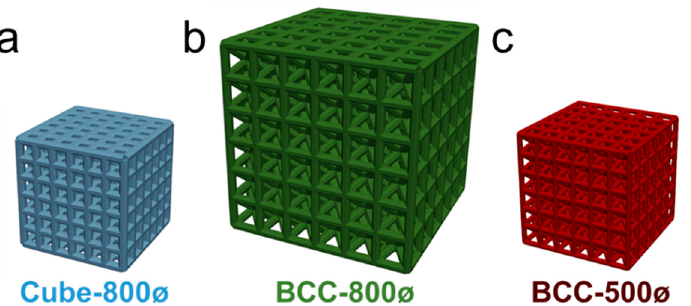
Figure 1. Designs of 40% relative density for ( a ) Cube-800ø lattice with Cube unit cells with 800 µm beam diameters; ( b ) BCC-800ø lattice with BCC unit cells with 800 µm beam diameters; and ( c ) BCC- 500ø lattice with BCC unit cells with 500 µm beam diameters.